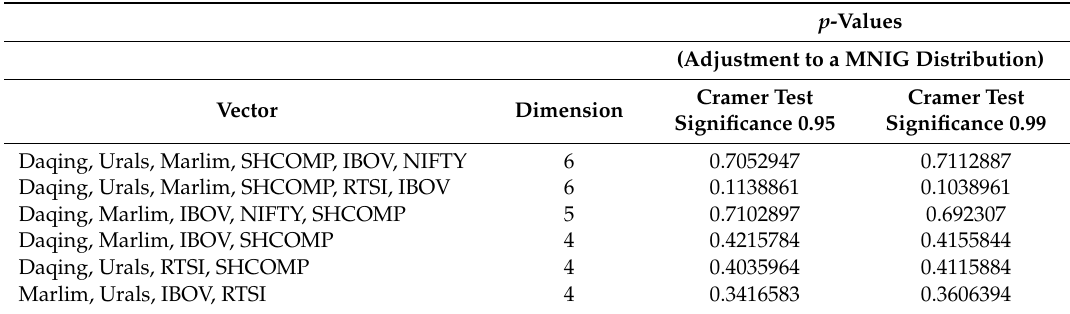
Table 2. p -Values for every proposed vector using the Cramer test considering a Multivariate Normal Inverse Gaussian (MNIG) distribution. In all cases the p-values are not statistically significant and indicate strong evidence for the null hypothesis. Elaborated by authors with data from Bloomberg.